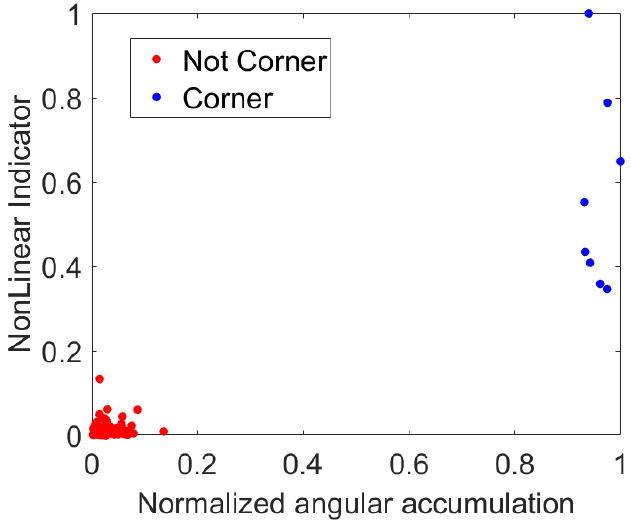
Figure 9. Subdivide the denoised signal and calculate features. ( A ) The initial building outline; ( B ) (absolute value); ( D ) the magnified view of the denoised signal from 306 to 327.